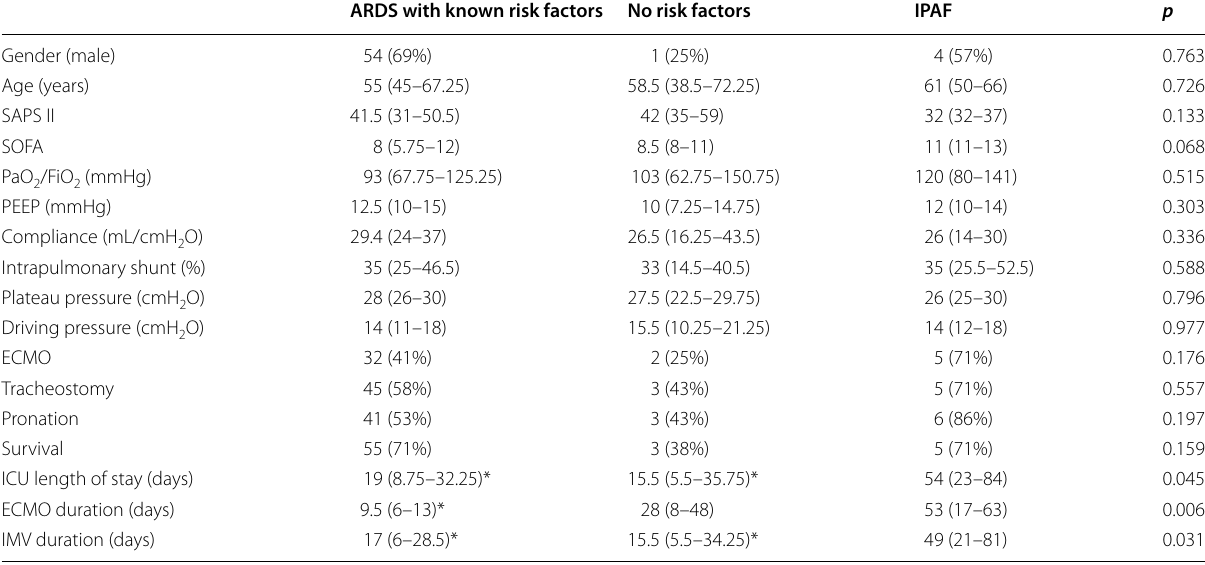
Data are presented as absolute frequency (% of the included patients) or as median and interquartile range IPAF interstitial pneumonia with autoimmune features, SAPS II Simplified Acute Physiology Score, SOFA Sequential Organ Failure Assessment, PEEP positive end- expiratory pressure, ECMO extracorporeal membrane oxygenation, ICU intensive care unit, IMV invasive mechanical ventilation * p < 0.05 versus IPAF